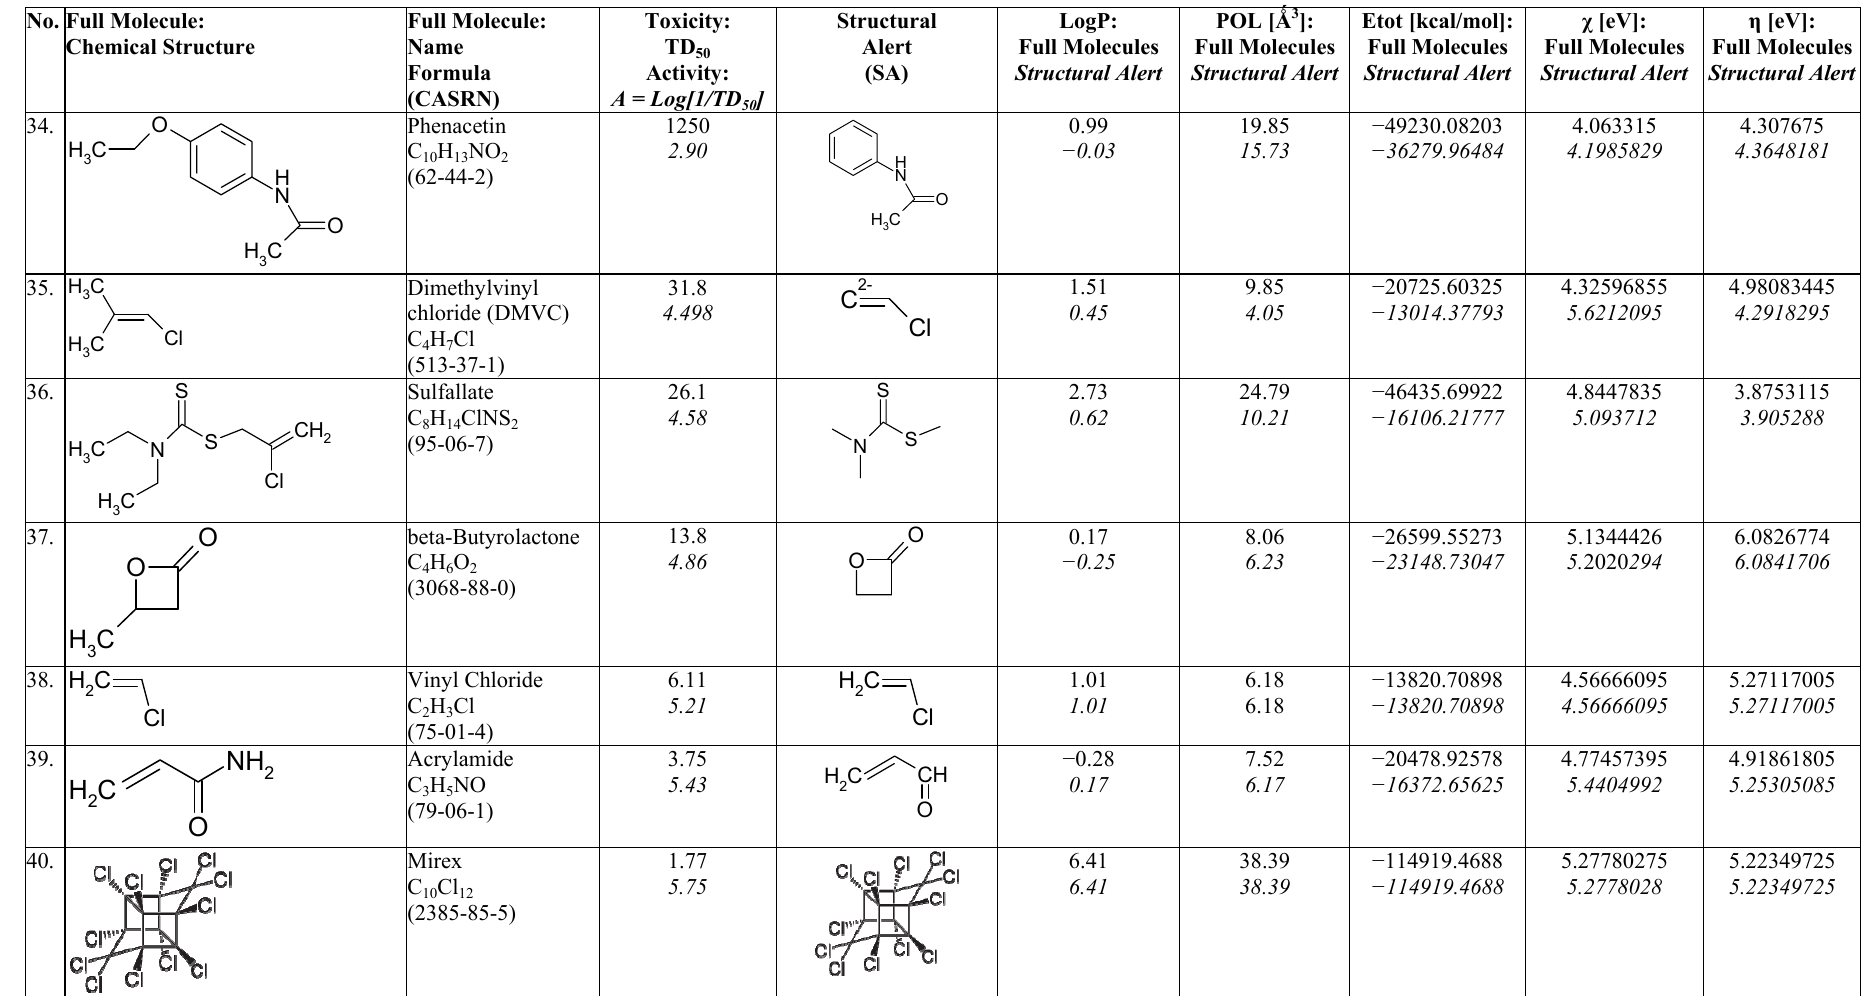
Table 2. Molecules from the quasi-Gaussian test set (Figure 2), with the activities and structural parameters as in Table